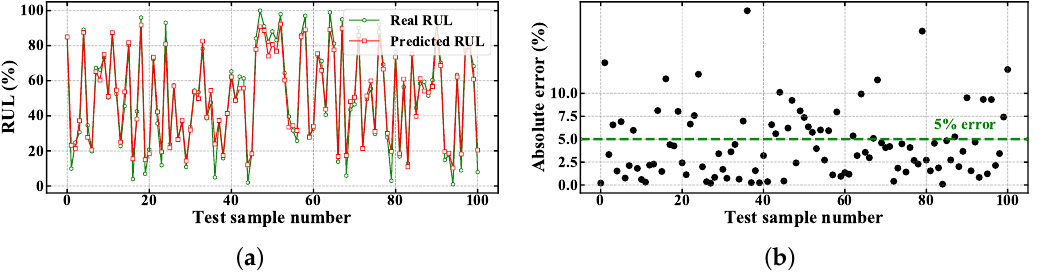
Figure 13. Results of experimental case 4. RUL prediction results and absolute errors when Battery #56 is the test set and Batteries #5, #6 and #7 are the training set: ( a ) The RUL prediction results. ( b ) The absolute